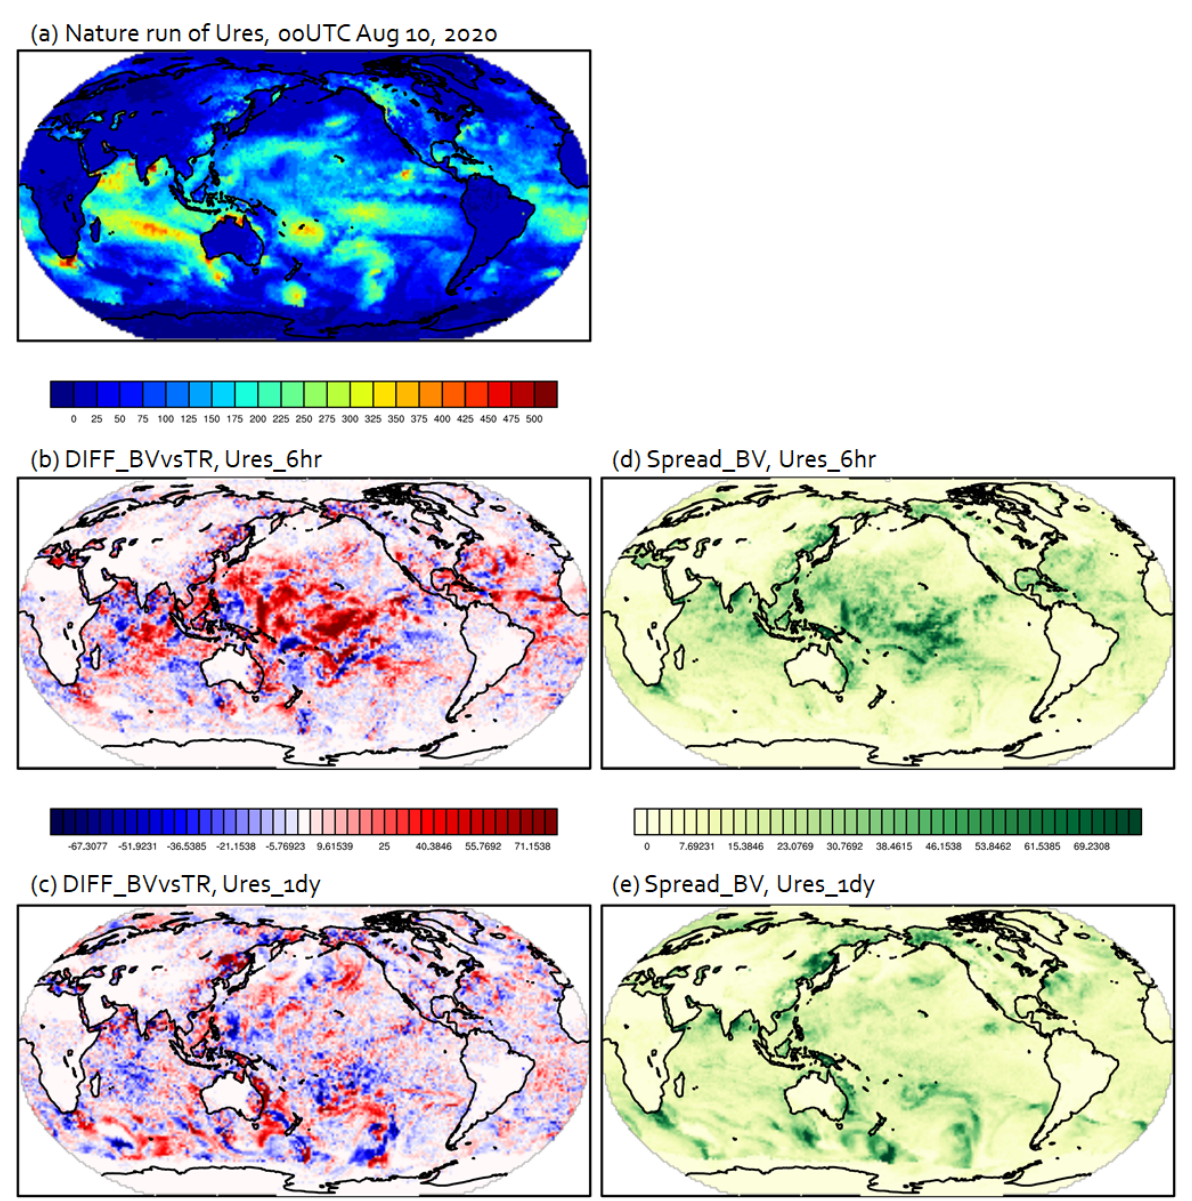
Figure 2. Surface latent heat flux (W/m 2 ) of ( a ) the nature run, ( b ) difference between the nature and the mean BVs with 6-h rescaling interval, ( c ) difference between the nature and the mean BVs with 1-day rescaling interval, ( d ) BVs spread with 6-h rescaling interval, and ( e ) BVs spread with 1-day rescaling interval from the experiments of Ures valid at 00UTC on 10 August 2020.